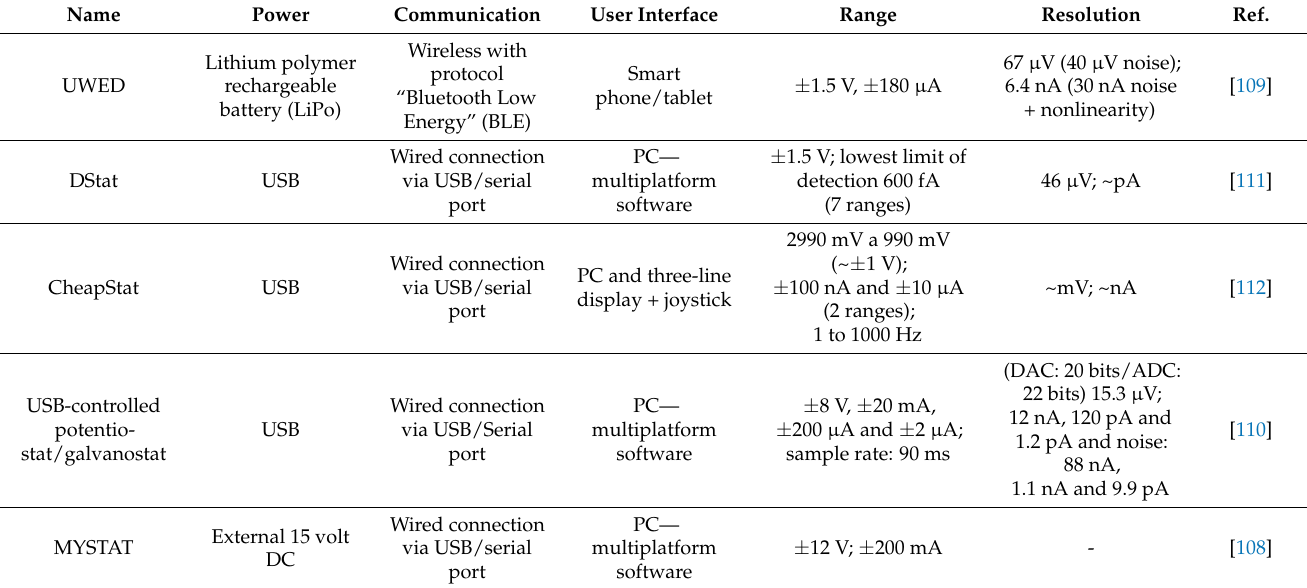
Table 5. Characteristics of open-source